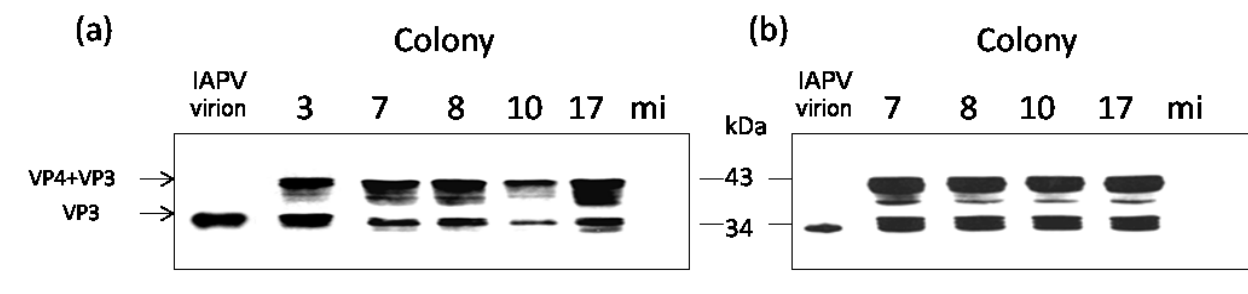
Figure 4. IAPV-virion proteins are synthesized in larvae injected with IAPV extracts of bees from CCD-colonies. Immunoblot analysis of protein extracted from virus-free larvae injected with IAPV extracts from colony samples (indicated above the figure). Panels ( a ) and ( b ), injection of IAPV samples from July 2011 and February 2012, respectively. All viral samples were separated by PAGE and immunoblotted with anti-VP3 antiserum. Arrows, virion proteins recognized by the serum. Molecular size markers are indicated on the right. mi, control mock-injected larvae with extracts derived from healthy